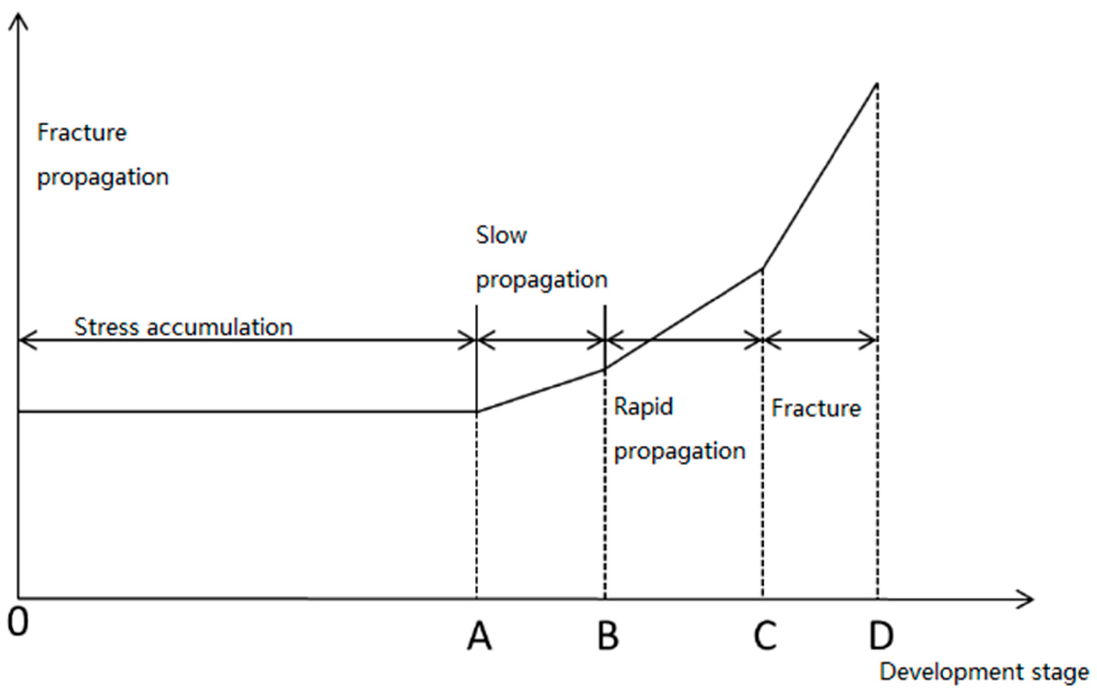
Figure 8. Relationship between fracture propagation and discharge.